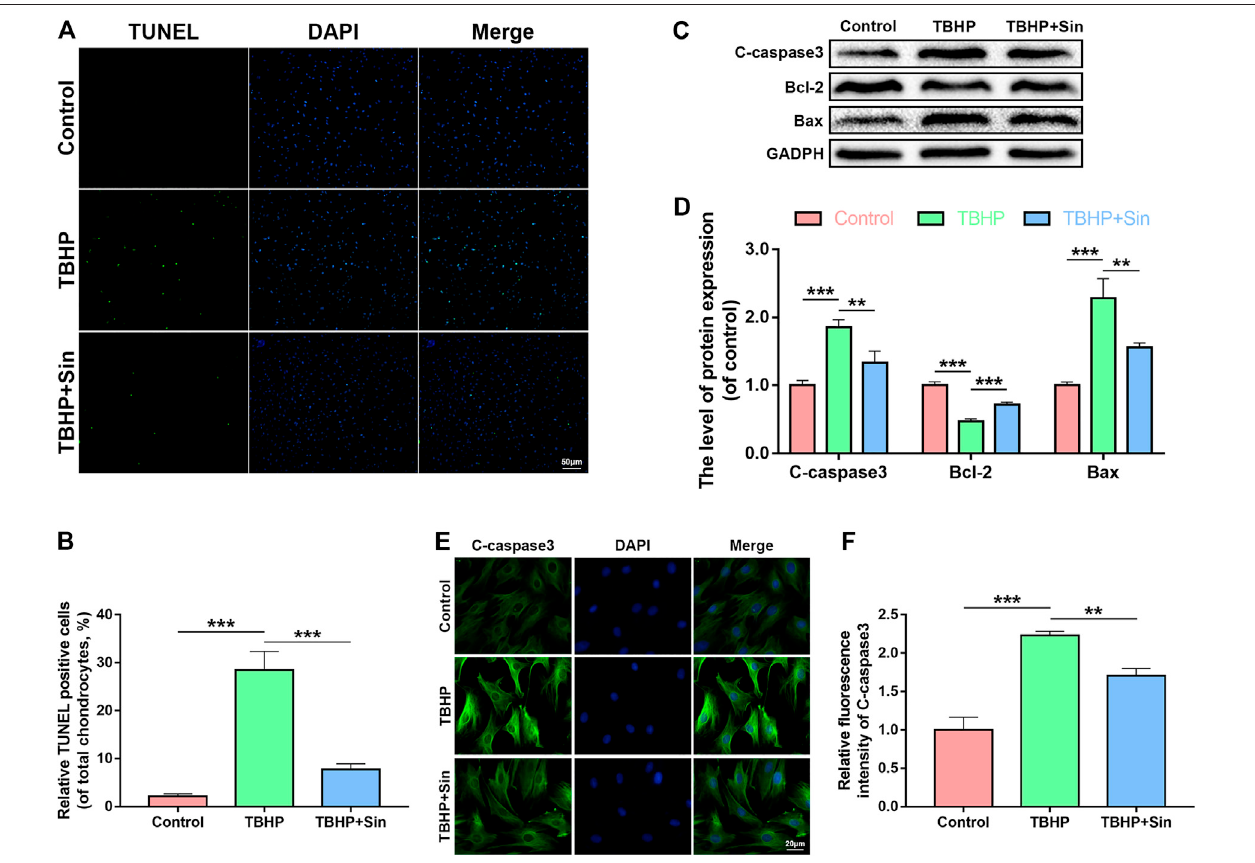
FIGURE 2 | Sin protects TBHP-treated chondrocytes from apoptosis. (A, B) The results of TUNEL assay show the number of TUNEL-positive chondrocytes treatedwithorwithout40 μ MSinfor24 hand30 μ MTBHPfor24 h(Scalebar:50 μ m). (C,D) Theresultsofwesternblottingshowthelevelsofcleavedcaspase3,Bcl-2 andBaxproteinsinthechondrocytesastreatedabove. (E,F) Theresultsofimmuno fl uorescenceshowtheintensityofcleavedcaspase3inthechondrocytesastreated above (Scale bar: 20 μ m). The data are presented as the means ± SD ( n (cid:1) 3); * p < 0.05, ** p < 0.01, and *** p <